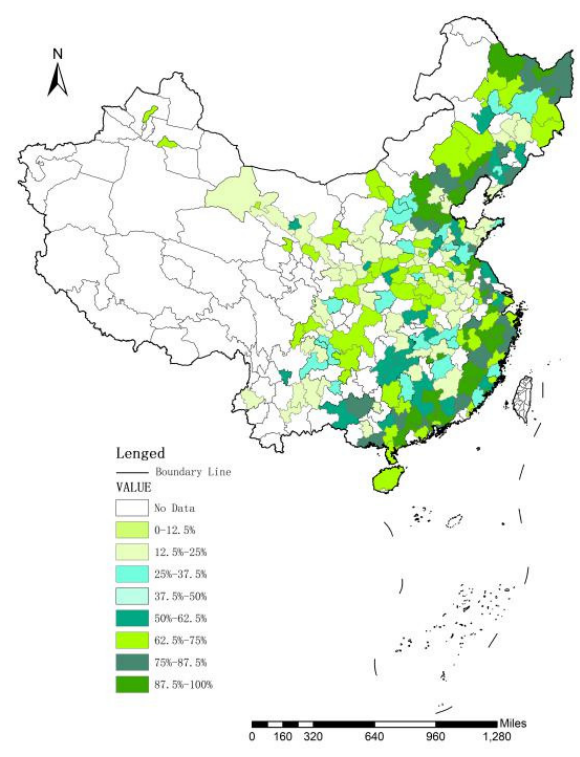
Figure 2. China’s urban ecological footprint in 2014.